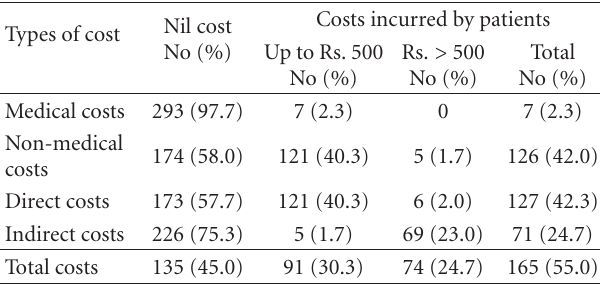
Table 4: Percentage of patients who incurred costs during intensive phase of